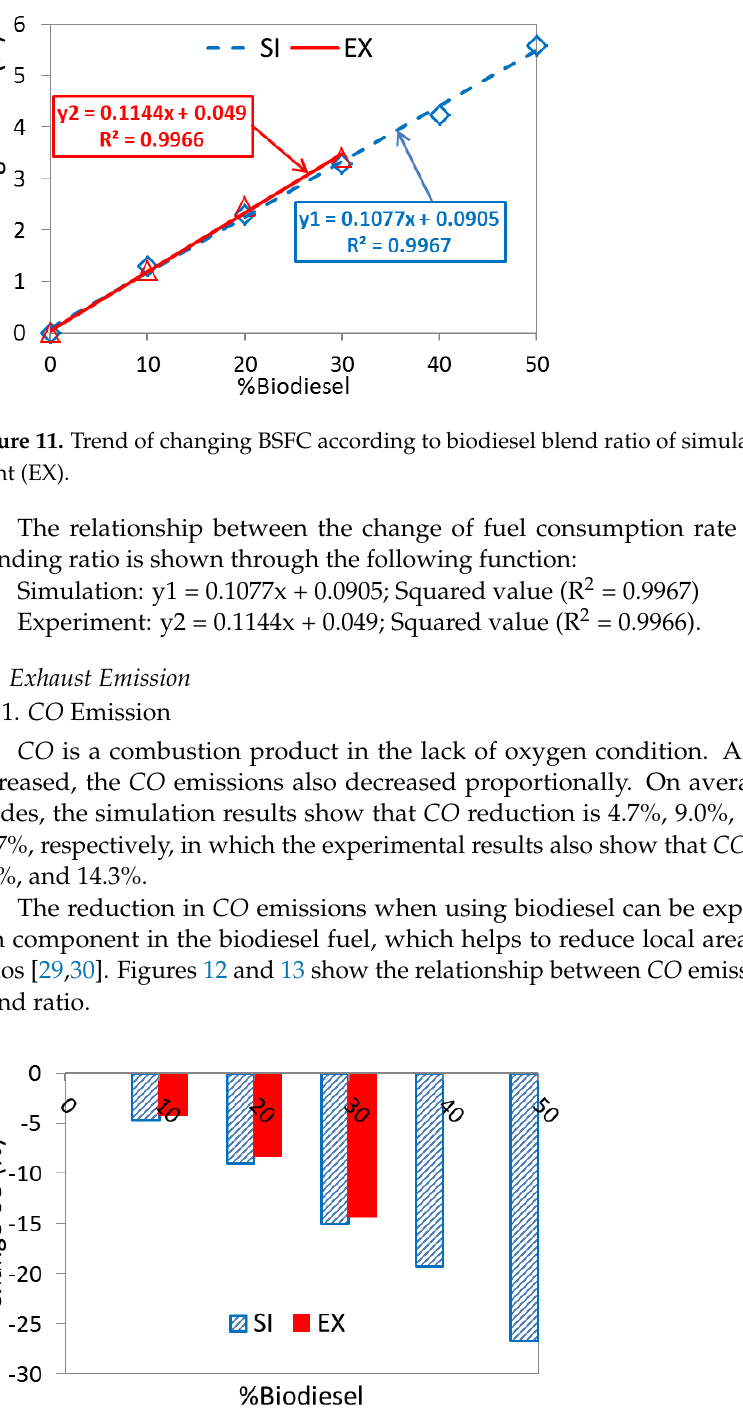
Figure 10. Relationship between BSFC and biodiesel blending ratio of simulation (SI) and experi- ment (EX).